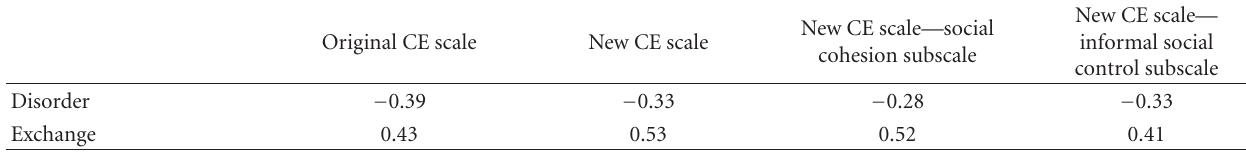
Table 3: Correlations of collective e ffi cacy scales and subscales with other neighborhood scales.